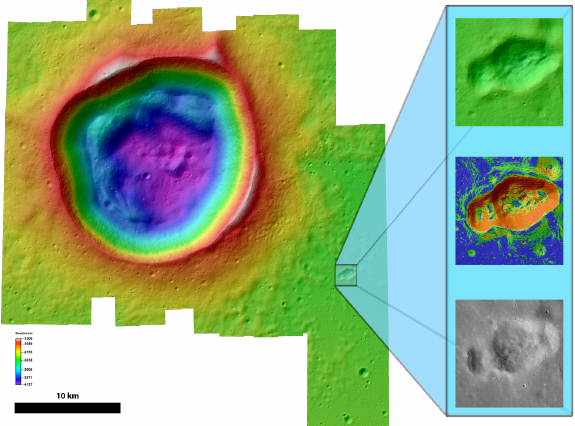
Figure 3. Color shaded relief terrain model derived from a NAC DEM mosaic of 13 stereo pairs of Lichtenberg Crater. The enlargements display color shaded terrain, slope map, and orthophoto derived from the DEM